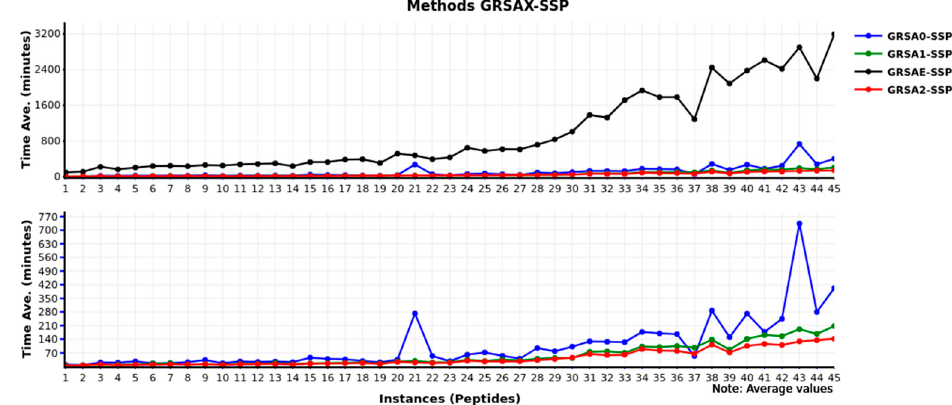
Figure 6. Comparison of GRSAX-SSP algorithms.